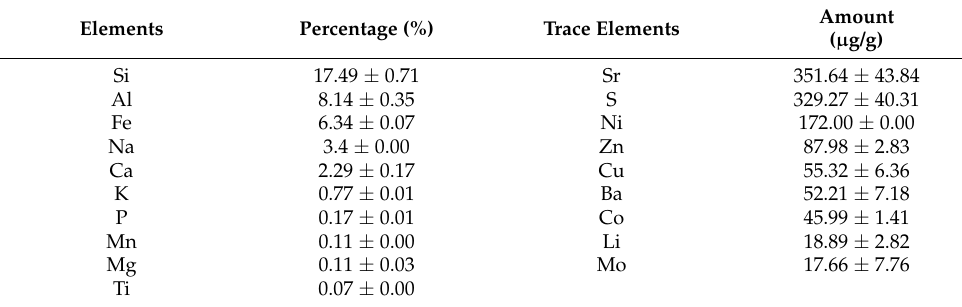
Table 2. Main elements present in the sample determined by